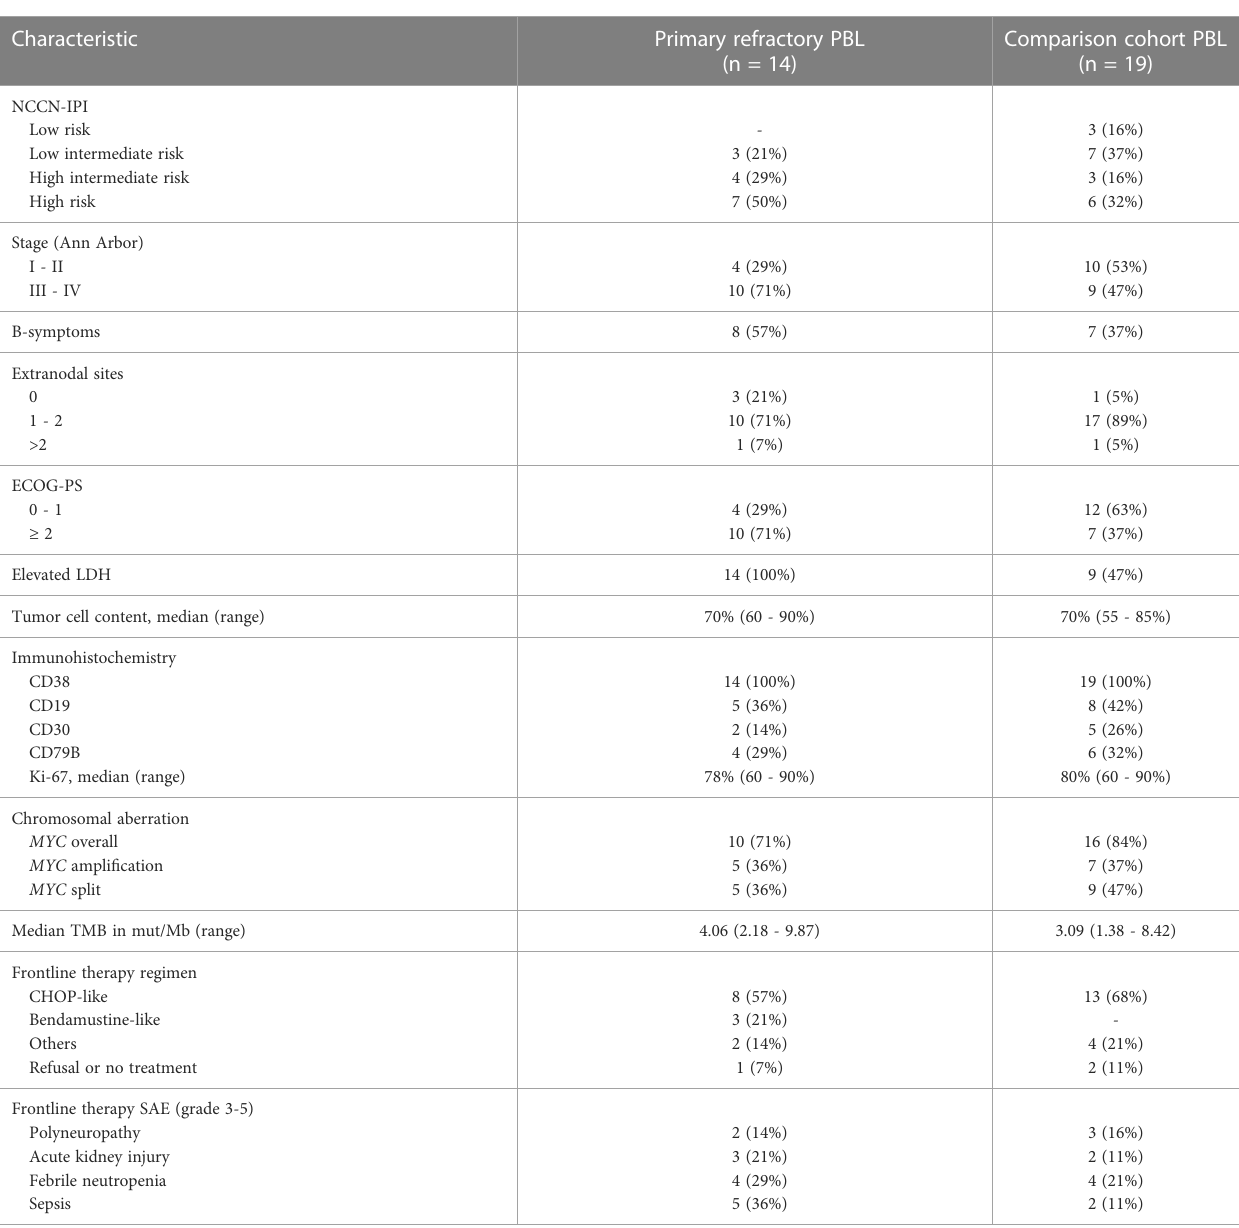
indels) and nonsense mutations (9.7%). Further investigations revealed loss of function (LOF) in 48.4% and gain of function (GOF) in 51.6% among the spectrum of mutations (Figure 2C). The median TMB was slightly higher in primary refractory cases (4.06 comparison cohort; Figure 2D; Supplemental Table 3). Given the limited sample size, this result was statistically insigni fi cant (p = 0.337). TMB values in PBL displayed an overall low to intermediate